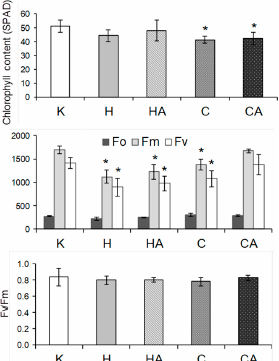
Figure 7. Changes in cauliflower leaf chlorophyll content minimal (Fo), maximal (Fm) and variable (Fv) fluorescence and Fv/Fm ratio in control grown ( K ), cold-stressed ( C ), heat-stressed ( H ), cold-recovered ( CA ) and heat-recovered ( HA ) plants. Chlorophyll content measured with a chlorophyll meter was expressed in relative units. Chlorophyll fluorescence was measured using a portable fl uorometer. Before measurement, leaves were dark adapted for 30 min. Photochemical efficiency of PSII could be estimated from the Fv/Fm ratio, where Fv is the difference between Fm and Fo. Bars are means ± SD ( n > 3) and asterisks indicate significant differences ( p < 0.05; Student’s t -test) from the control ( K ). Further experimental details in ‘Materials and